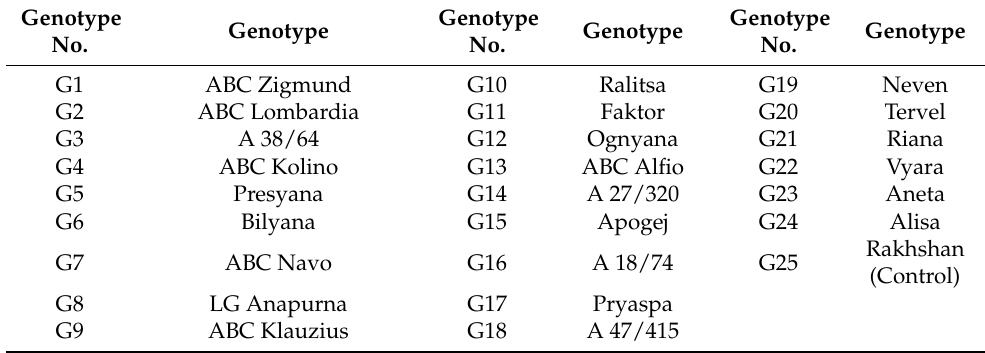
Table 1. Names and code of wheat genotypes studied in the experiment.